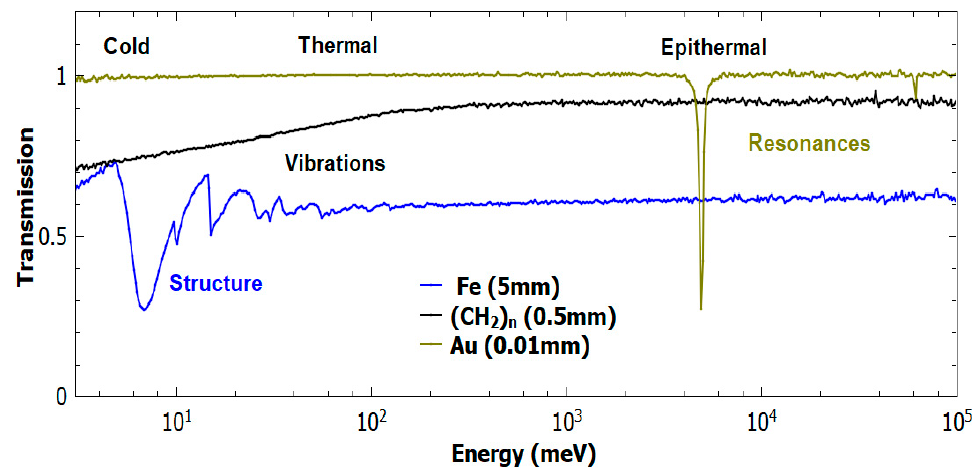
Figure 1. The total neutron cross section of a series of materials as function of the incident neutron energy, as measured on the VESUVIO spectrometer [16]: a 5-mm-thick iron slab (blue), a 0.5-mm-thick polyethylene foil (black) [17] and a 0.01-mm-thick gold foil (gold). The energy ranges for cold, thermal, and epithermal neutrons are also indicated.